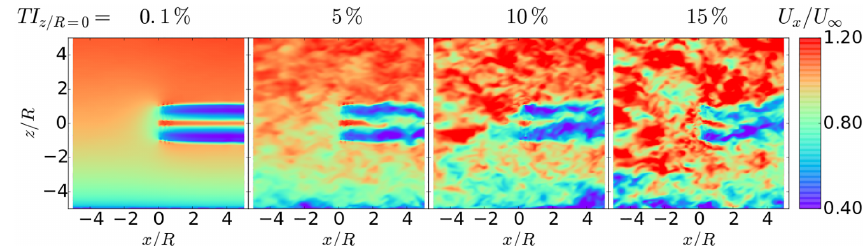
Figure 15. Vertical plane of the instantaneous axial velocity component U x of wind turbine wake immersed in shear turbulent flow.